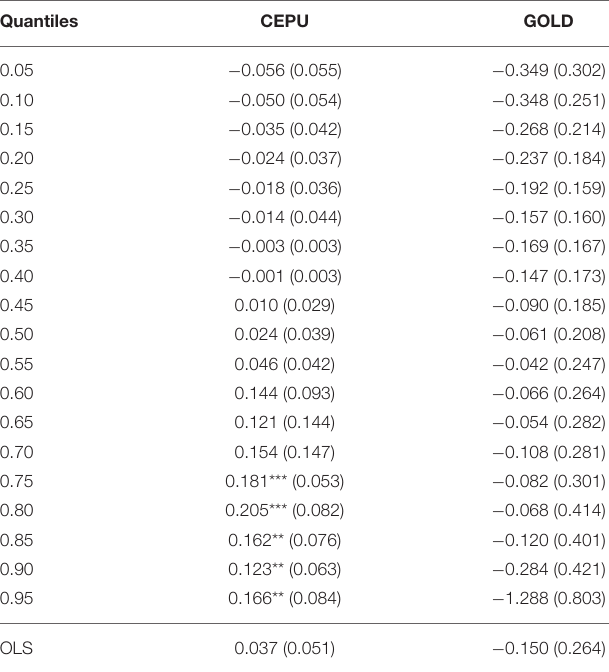
TABLE 2 | Results of the OLS and the GQR estimations (extended model with gold